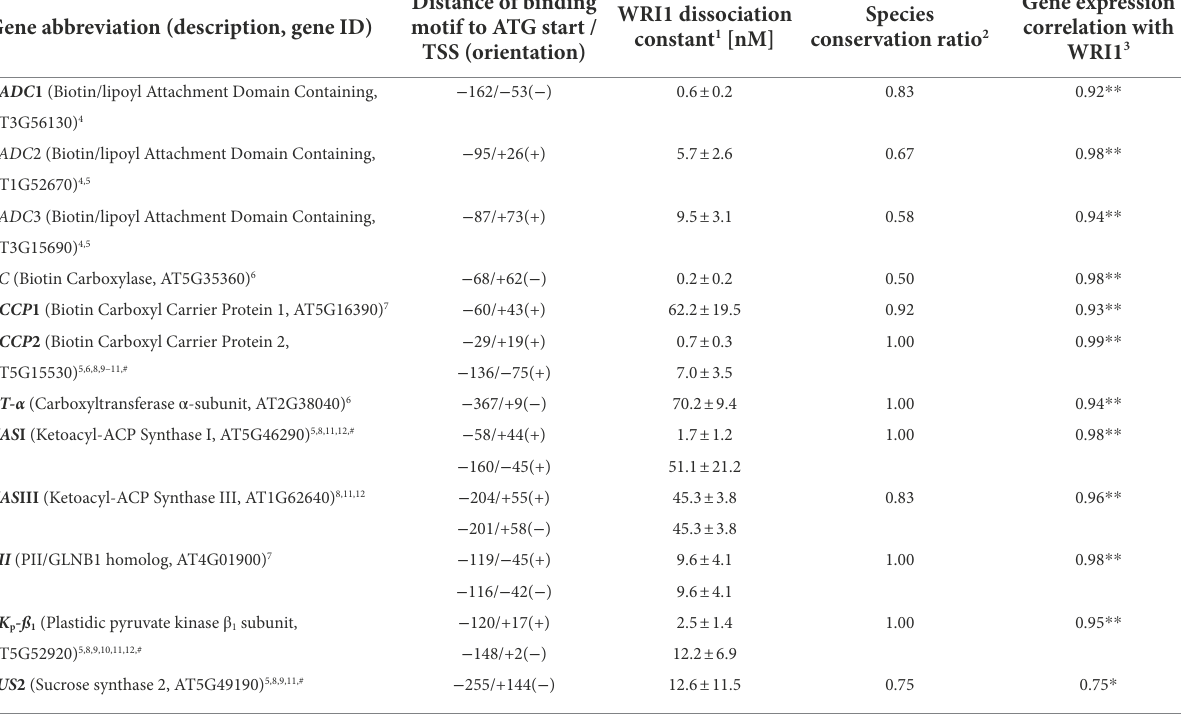
TABLE 5 Examples of gene targets in fatty acid biosynthesis which have previously been characterized by genetic and biochemical evidence.